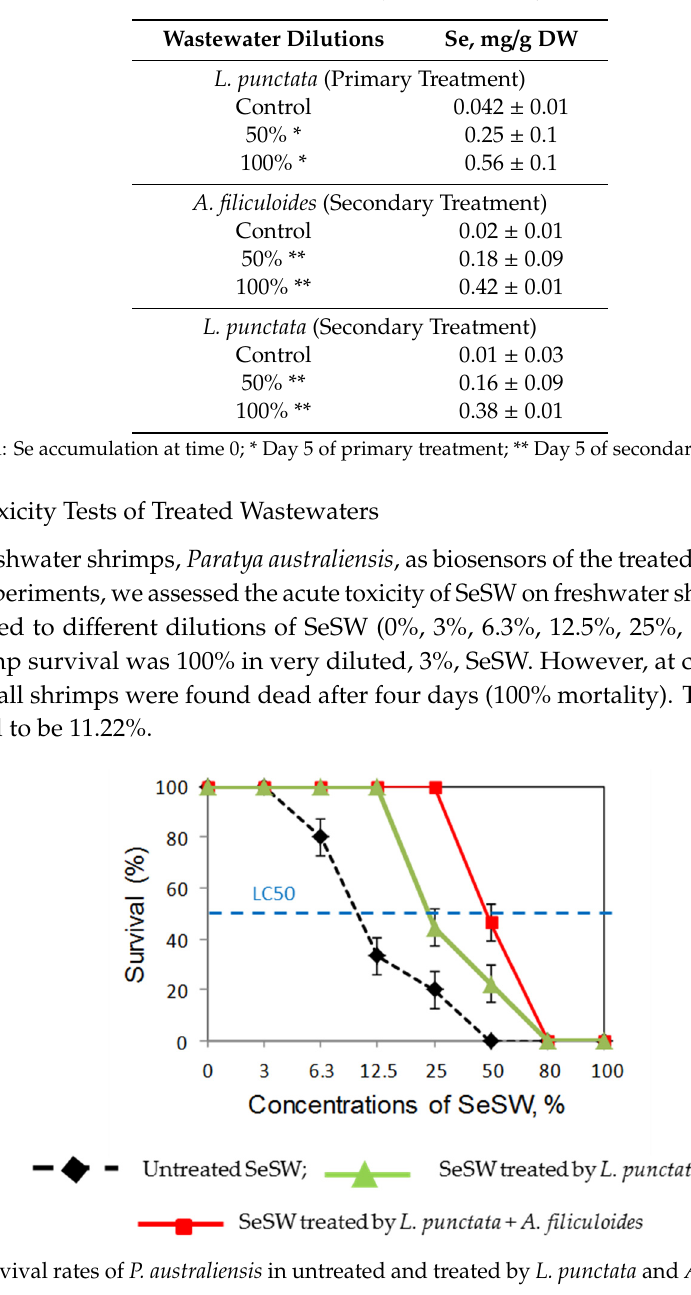
Table 2. Selenium accumulation in L. punctata and A. filiculoides biomass.